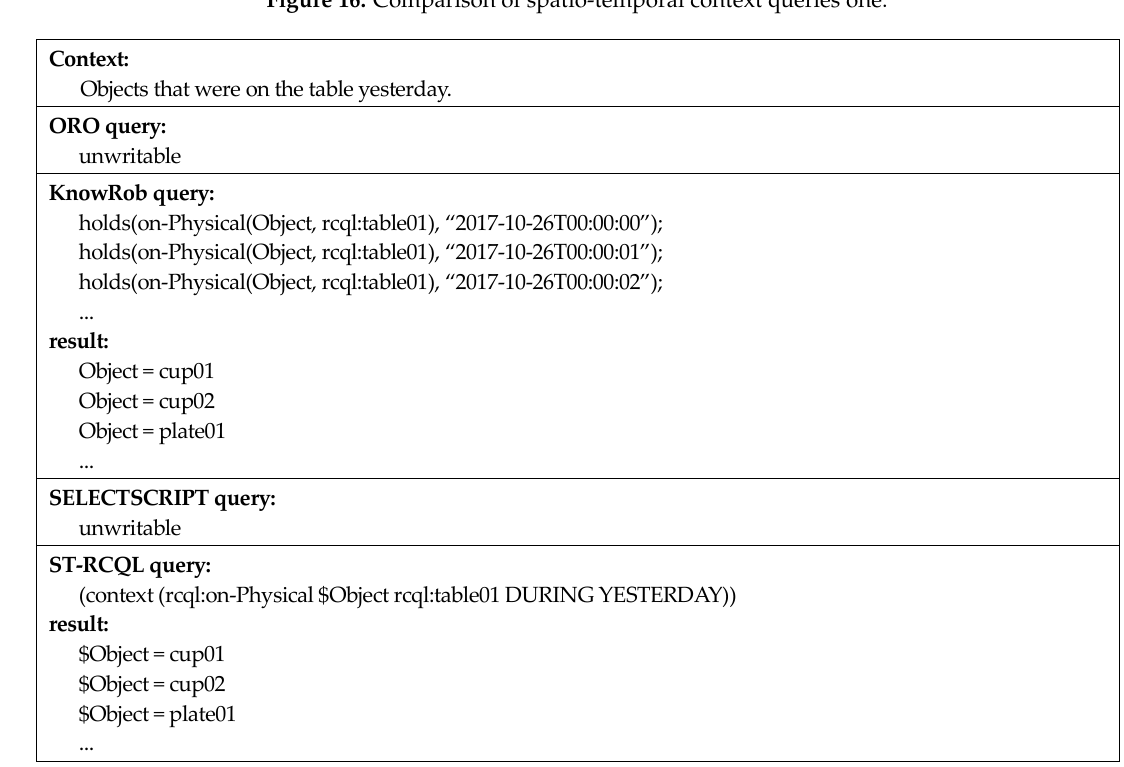
Figure 17. Comparison of spatio-temporal context queries two.